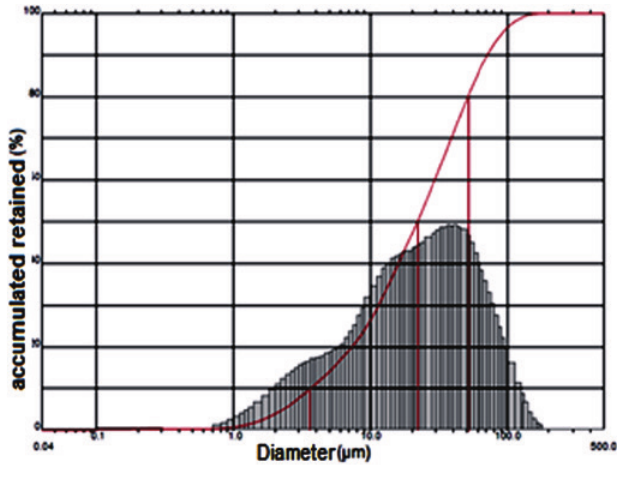
Granulometric distribution curves of